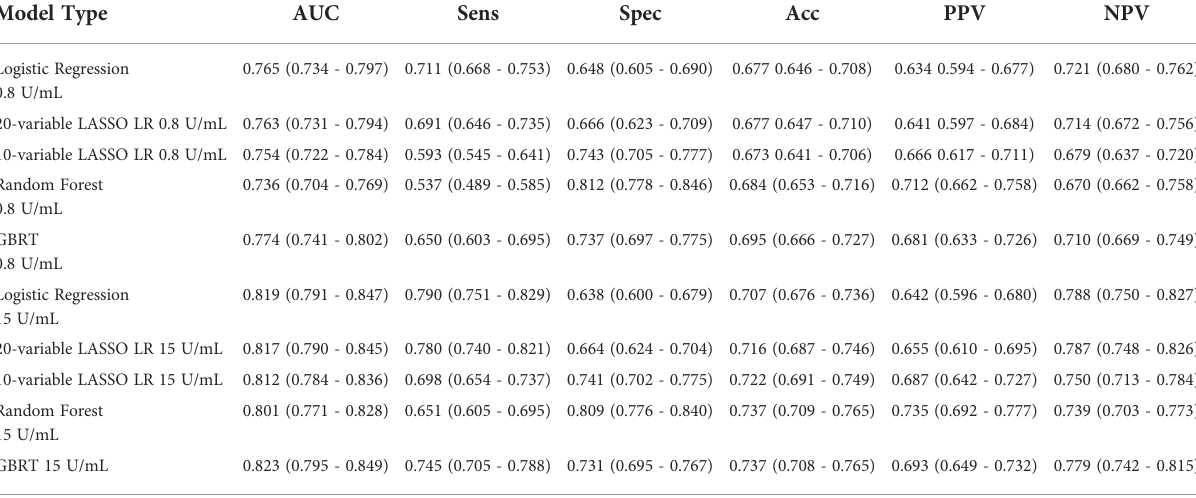
TABLE 7 Performance of all fi ve different models during external validation on the pooled validation datasets. Model